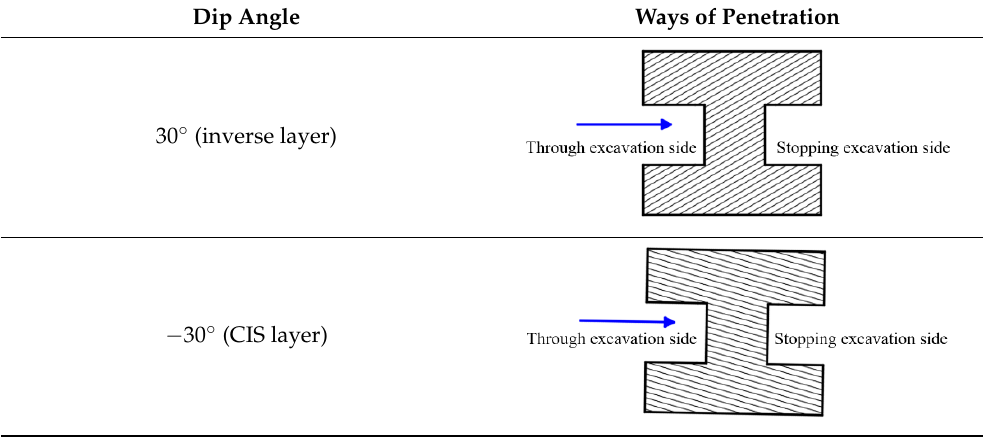
Table 5. Schematic diagram of through excavation cis-layer and inverse layer. Dip Angle Ways of Penetration